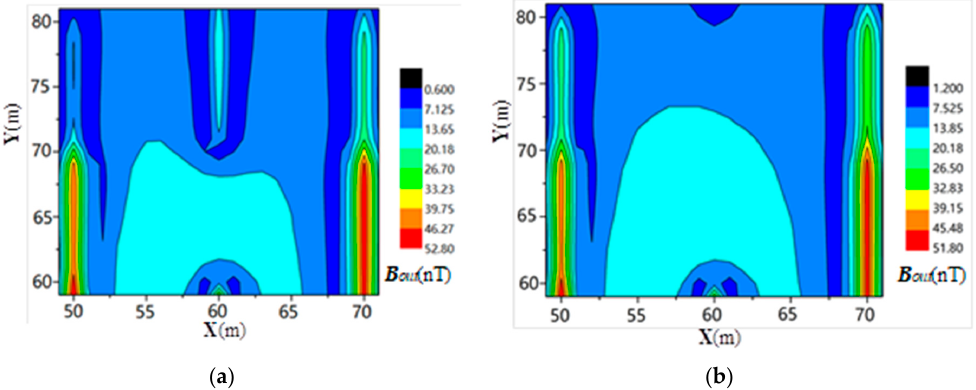
Figure 8. Measurement results of the current injection method [24] for ( a ) one breakpoint and ( b ) two breakpoints.